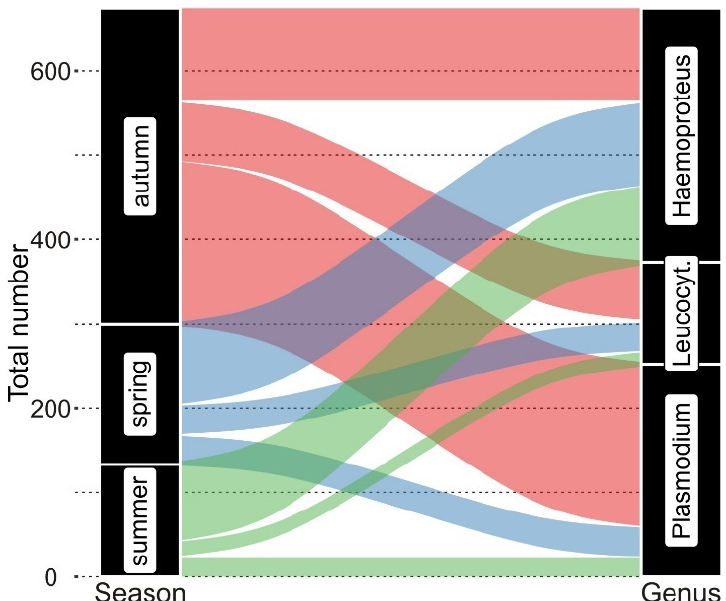
Figure 3. Alluvial plot describing the community structure of haemosporidian parasites detected in Drienovec, Slovakia, during 2017, 2018 and 2019. Community structure is described in terms of time of year (spring, summer, autumn) and parasite genus ( Haemoproteus , Plasmodium and Leucocytozoon ). We identified 53, 14 and 44 cytochrome b lineages for Haemoproteus , Plasmodium and Leucocytozoon , respectively, in birds of 35 avian species (Table 1). A total of 19 lineages (10, 1, and 8 for Haemoproteus , Plasmodium , and Leucocytozoon , respectively) were detected for the first time by this study (Table 1). While the richness of haemosporidian lineages was relatively higher in spring and autumn than summer, lineage diversity was markedly higher in spring than summer and autumn (Table 2). The latter result was largely due to the high diversity of Leucocytozoon lineages in spring (Table 2). A similar number (5–6) of lineages dominated in Haemoproteus and Plasmodium , but only a single lineage dominated in Leucocytozoon (Figure 4). While the dominant Haemo- proteus lineages, with the exception of TURDUS2, were regularly detected throughout the whole season, the dominant Plasmodium and Leucocytozoon lineages occurred predomi- nantly in autumn (Figure 4). The most frequently detected haemosporidian lineages during spring and summer comprised five Haemoproteus (spring: SYAT03 and SYAT16; summer: SYAT03, SYAT02, PARUS1, and TURDUS2) and five Plasmodium (spring: SGS1, TURDUS1, LINN1, SYAT05, and GRW11) lineages (Figure 4). Intra-generic multiple infections (infections involving different lineages of the same haemosporidian genus) were revealed for all the three haemosporidian genera, but multiple infections with more than two lineages were only detected in a single sample for Plasmodium (Table 3). The proportion of multiple ( ≥ double) infections was relatively higher in summer than spring and autumn for all the genera (the relationship between the type of infection, single vs. multiple, and time of year, Haemoproteus : χ 2 = 7.7, df = 2, p = 0.021; Plasmodium : χ 2 = 11.18, df = 2, p < 0.01; Leucocytozoon : χ 2 = 13.23, df = 2, p <